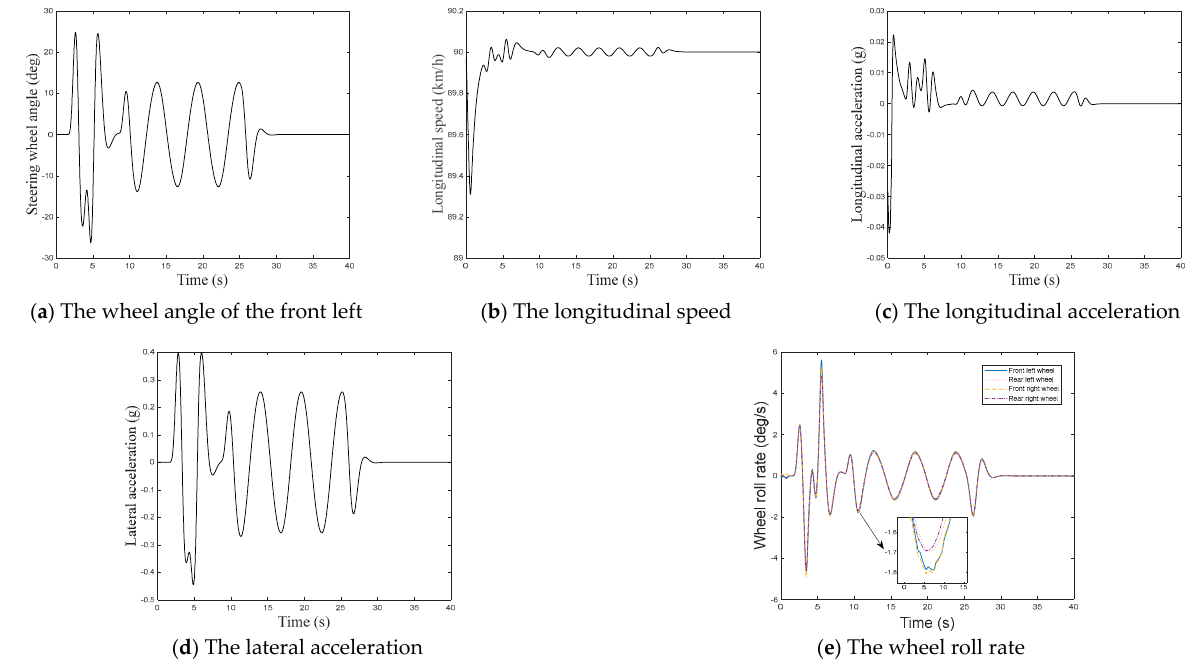
Figure 10. The wheel angle of the left front, longitudinal velocity, longitudinal acceleration, lateral acceleration, and wheel roll rate.